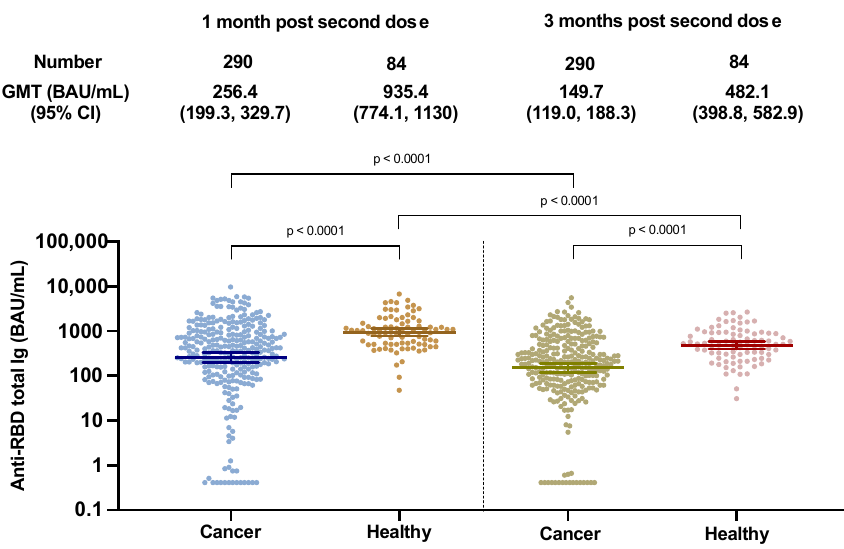
Figure 1. SARS-CoV-2 binding antibody levels at 1 and 3 months after two doses of the ChAdOx- nCoV-19 vaccine in cancer and healthy cohorts.